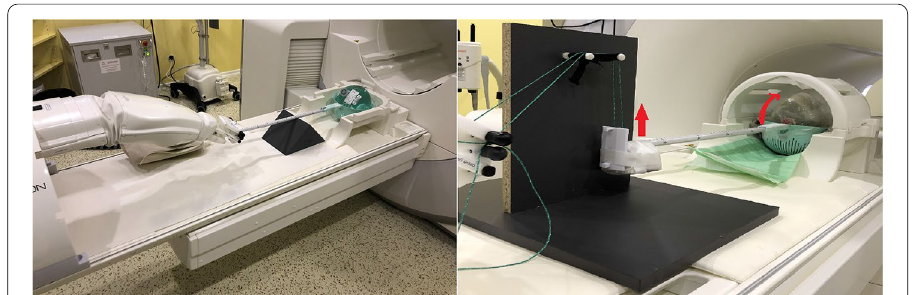
Fig. 3 InnoMotion robot system and experimental setup for generating a translation motion (left). Extension of the setup to create rotations around the transverse axis (right). The pulling motion of the robot arm can be converted into a rotational motion (see red